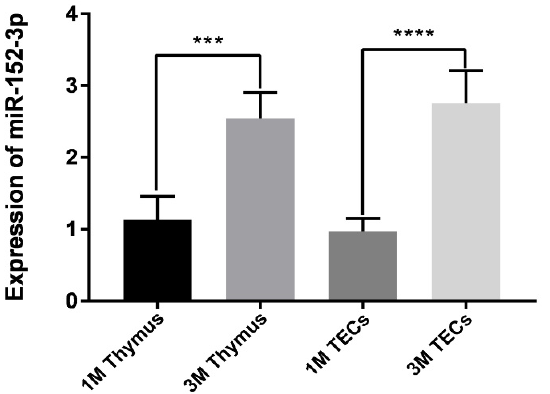
Figure 1. The expression of miR-152-3p from isolated thymuses and thymic epithelial cells (TECs). The miR-152-3p from the thymuses and TECs of 1 M and 3 M mice were quantified using RT-qPCR. Data represent the mean ± standard deviation ( SD) of three biological replicates (Student’s t -test: ***, p < 0.001; ****, p < 0.0001).